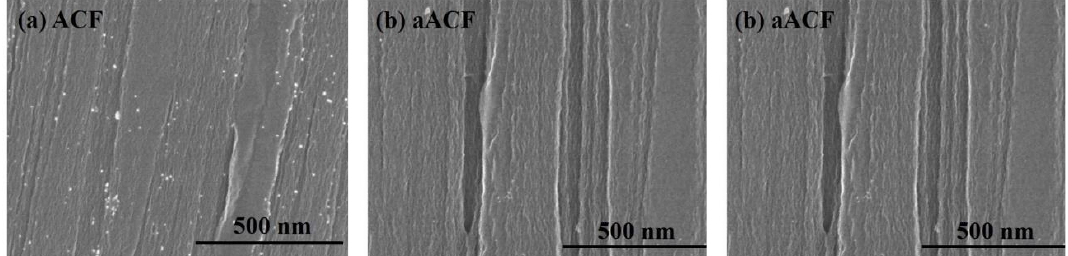
Figure 2. FESEM images of the samples: ( a ) as ‐ received ACF; ( b ) KOH ‐ activated ACF (aACF); ( c ) TEPA ‐ modified ACF (nACF).